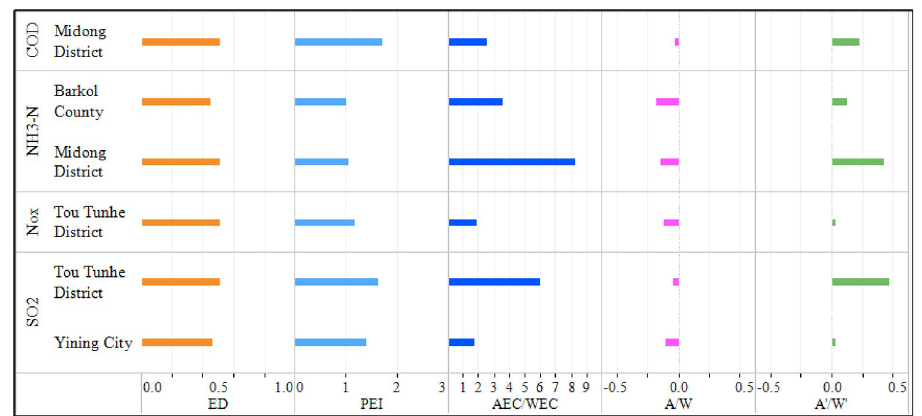
Fig 5. Causes of decomposition of pollutants in counties and cities with a “good ! poor” change trend (A is A EDI , W is W EDI , A’ is A EDI ’ and W’ is W EDI ’, as in Figs 6 and 7).